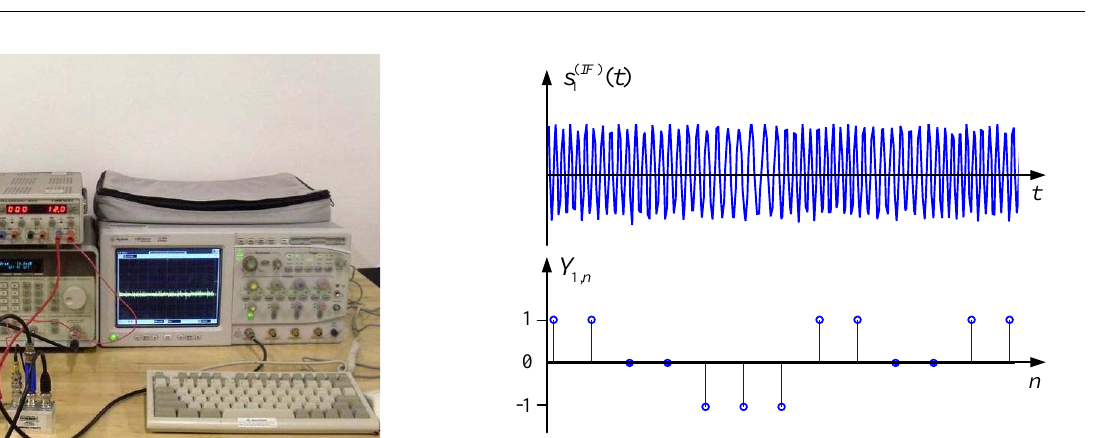
Figure 12. Waveform pieces of the IF signal and demodulator output acquired in the